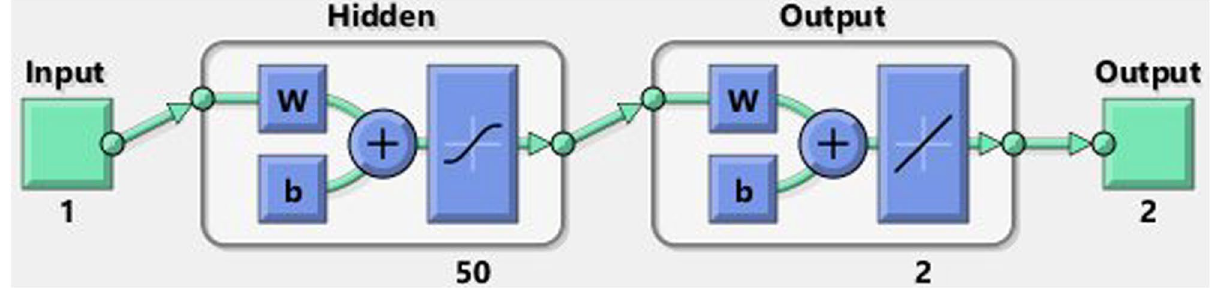
Figure 5. Design of suggested neural networks.